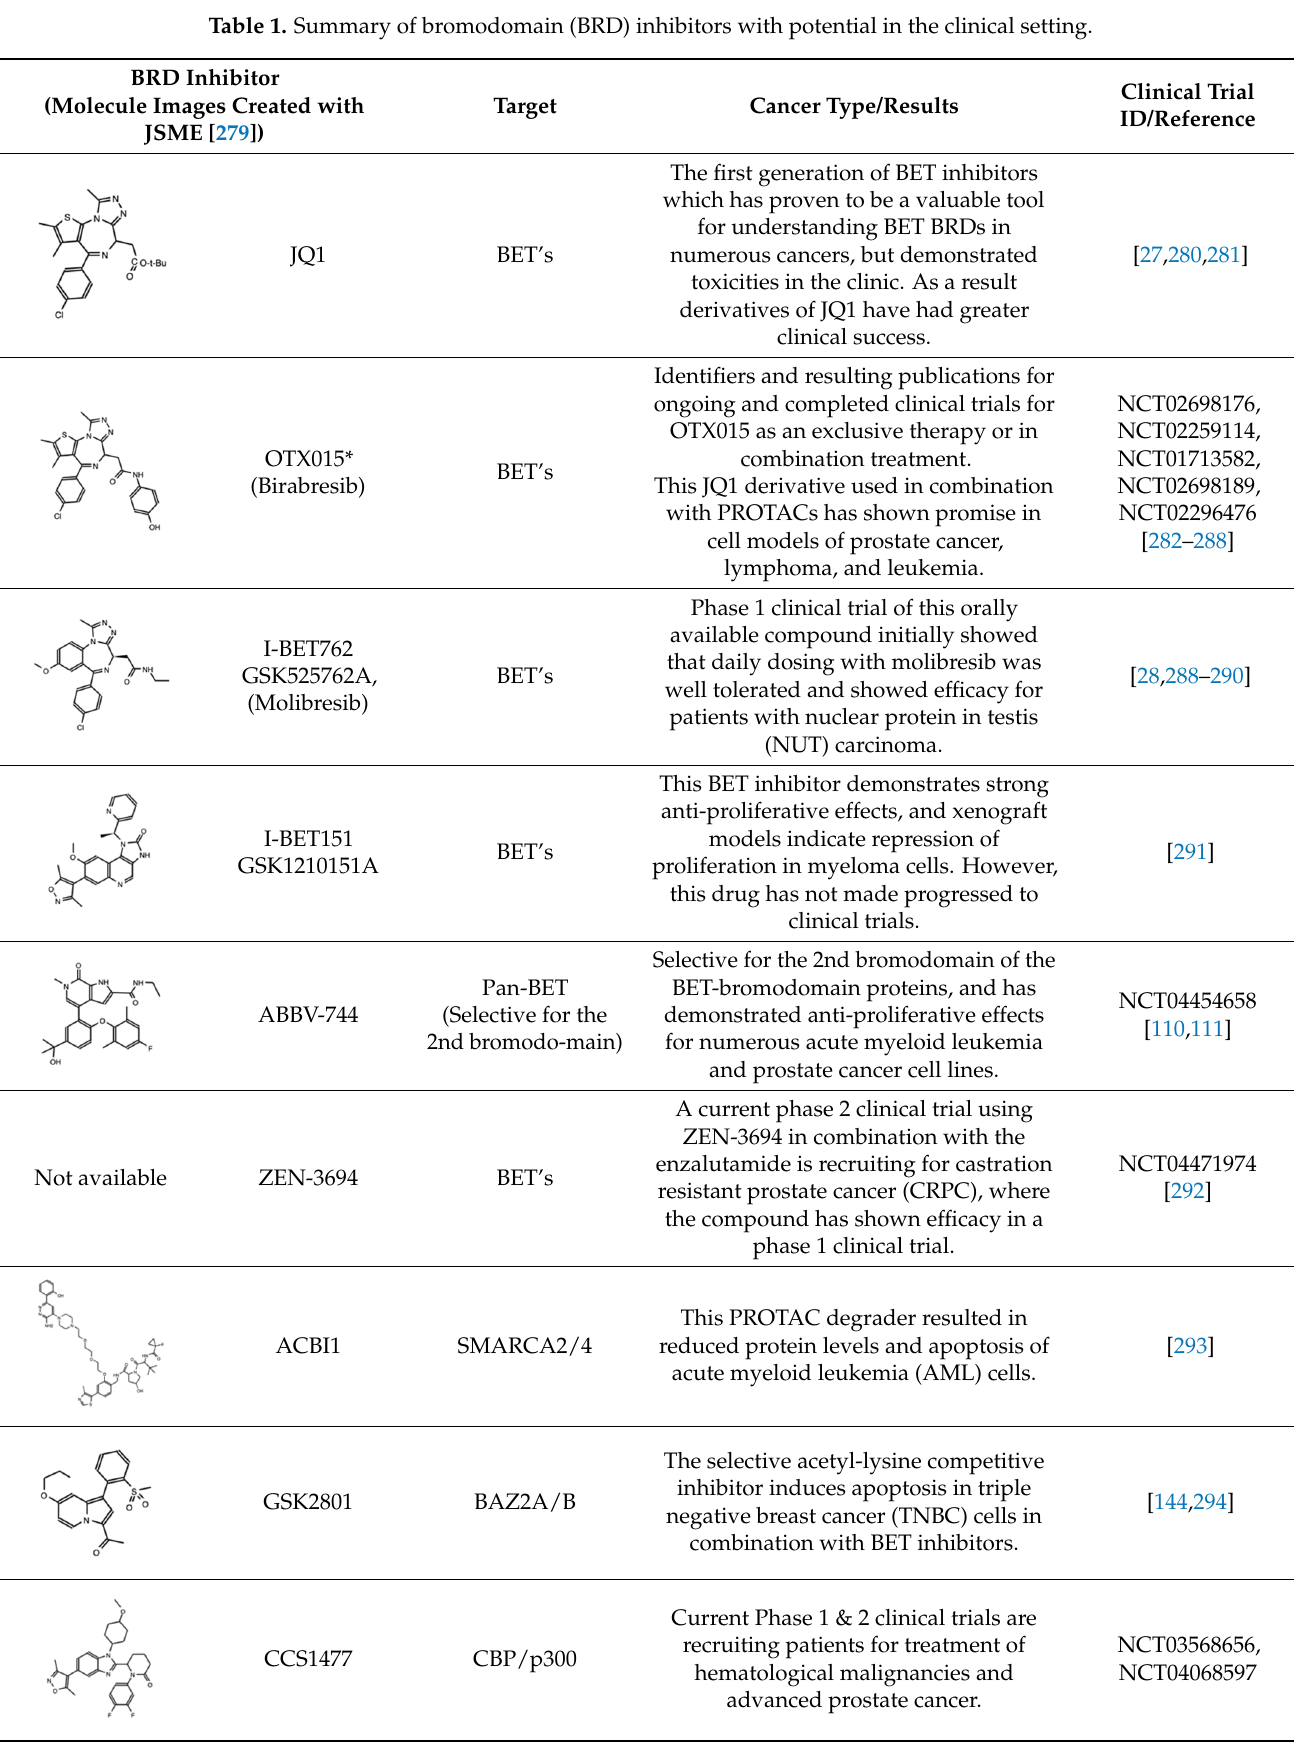
Table 1. Summary of bromodomain (BRD) inhibitors with potential in the clinical setting. BRD Inhibitor